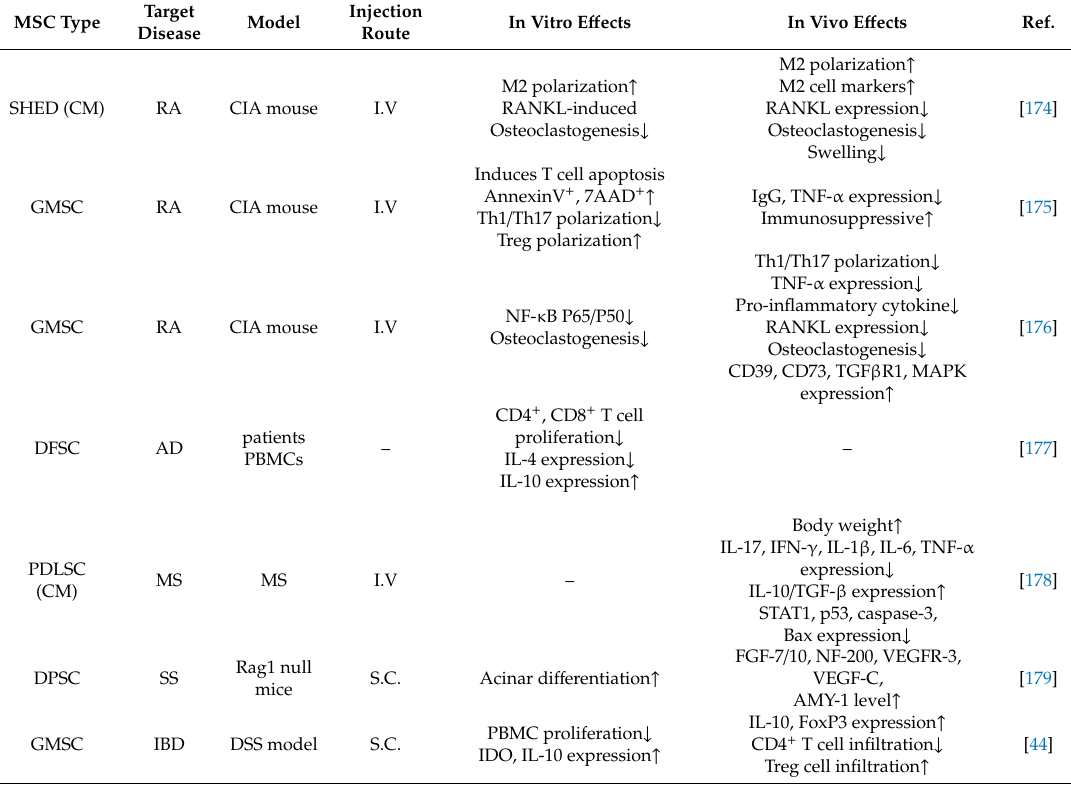
Table 3. Immunomodulatory capacity of dental MSCS targeting autoimmune diseases. MSC